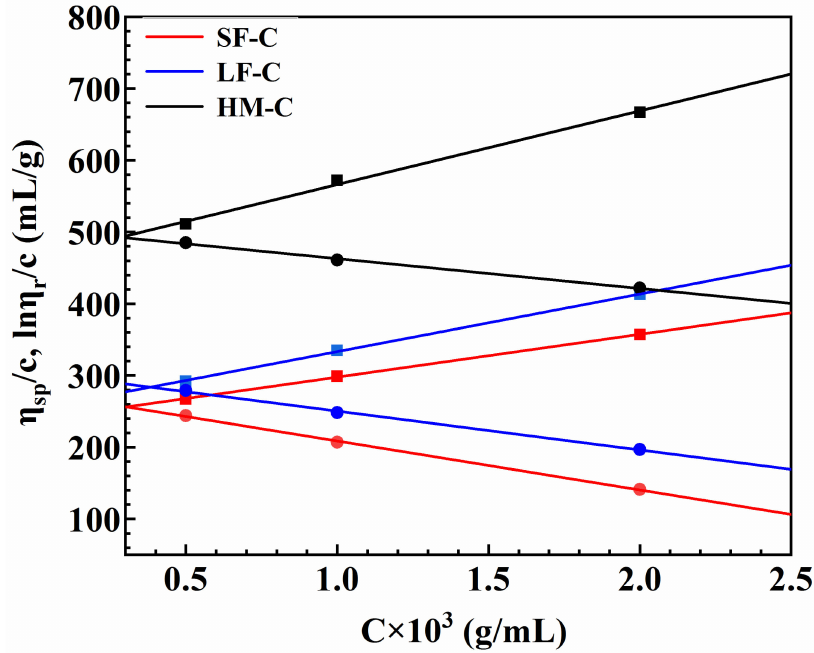
Figure 7. Dependence of intrinsic viscosity ([ η ]) on the concentration of three kinds of cellulose in 4.6-wt% NaOH / 15-wt% urea aqueous solution at 25 ◦